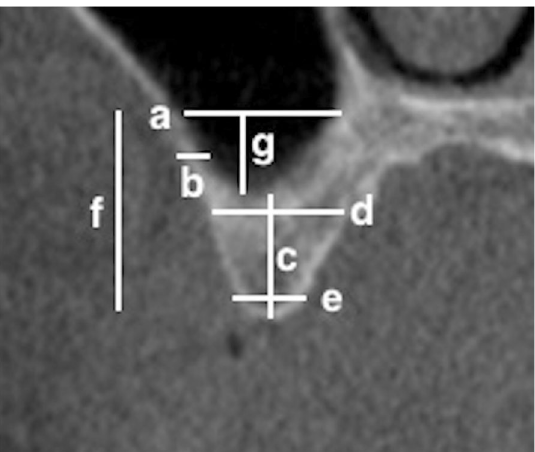
Figure 3. Explanation of linear measurements in CBCT considered in the study. ( a ) AAA; ( b ) Thickness of the lateral sinus wall; ( c ) Height of the residual alveolar ridge; ( d ) Width of the residual alveolar ridge (basal level); ( e ) Width of the residual alveolar ridge (crestal level); ( f ) Distance from AAA to the alveolar crest, ( g ) Distance from the AAA to the sinus